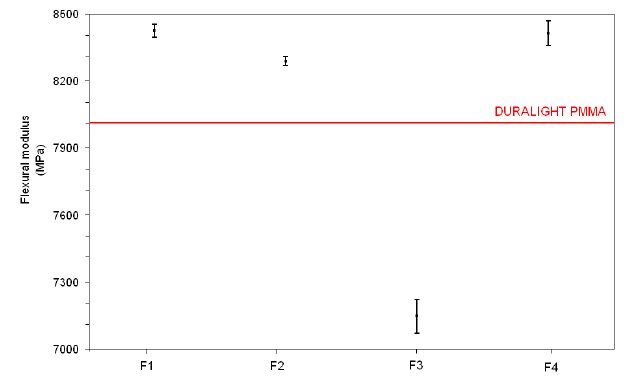
Figure 3. Flexural modulus results.